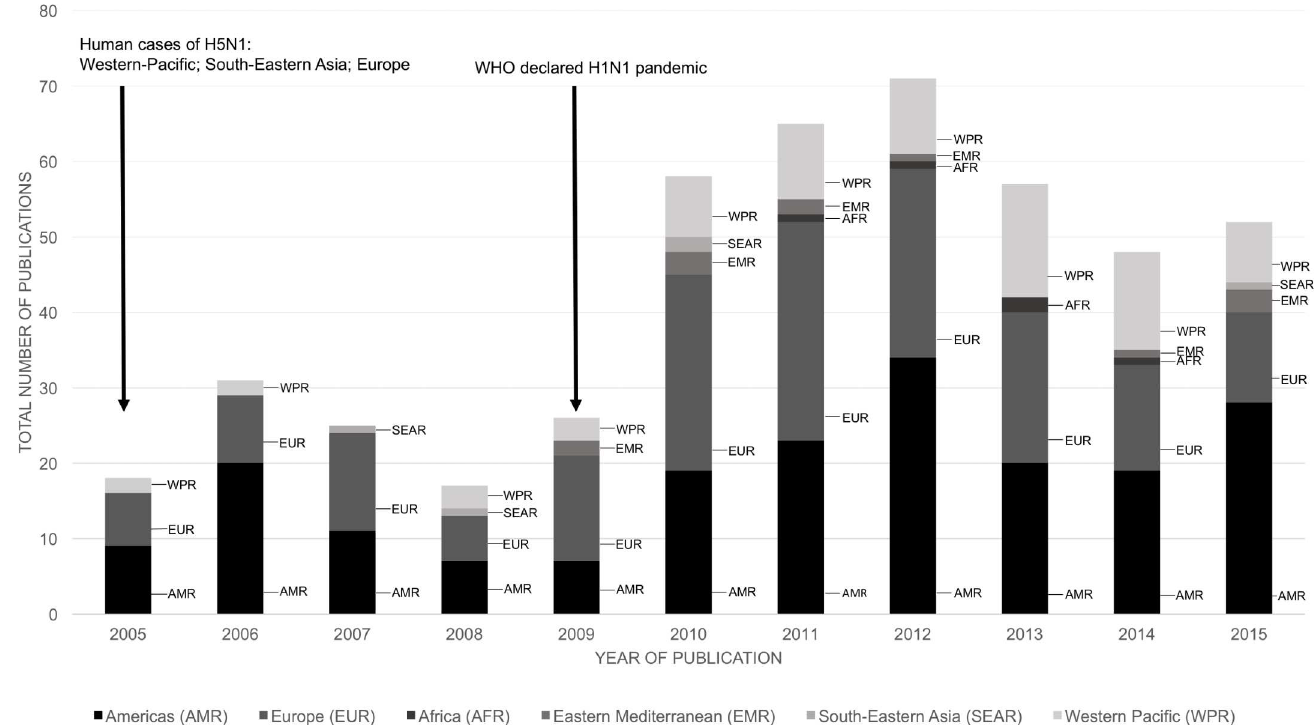
Fig 3. Total number of multivariate studies about influenza vaccine hesitancy by year of publication (2005–2015) and region (N =